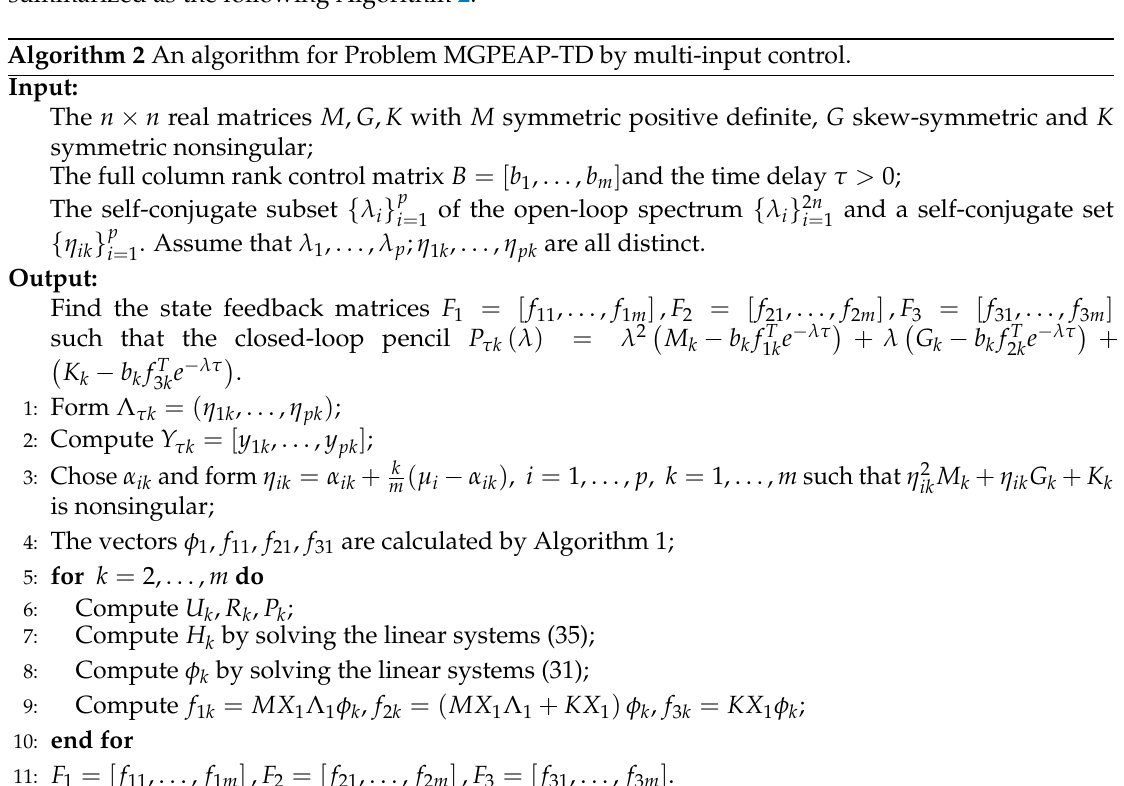
Algorithm 2 An algorithm for Problem MGPEAP-TD by multi-input